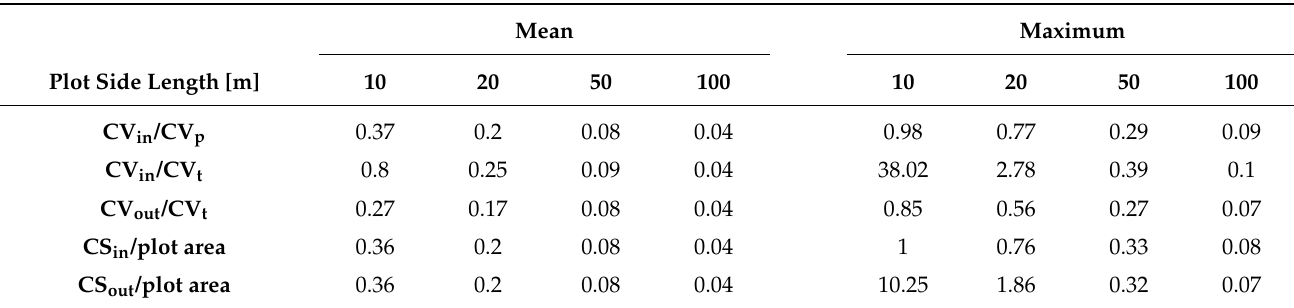
Table 2. Proportions of the crown volume (CV) and visible canopy surface (CS) for different plot sizes in the case of random variability in the crown diameter allometry. The values represent the means and maxima observed in the 50-ha investigation area.